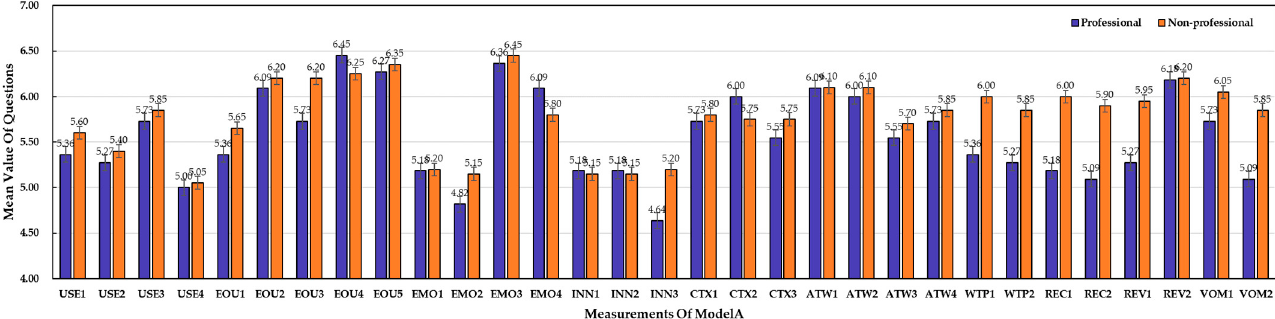
Figure 9. Comparison results of all measurements of Model A between professional and non-professional groups.